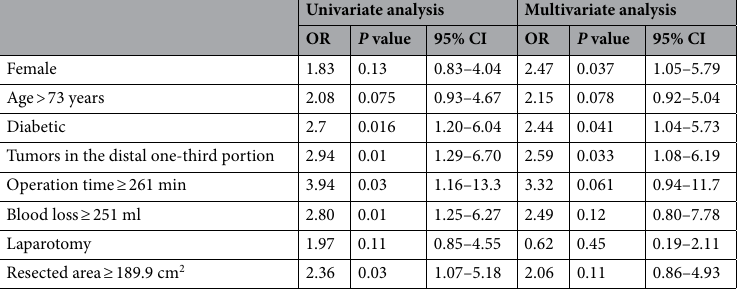
Table 3. Univariate and multivariate analyses of risk factors associated with delayed gastric emptying.